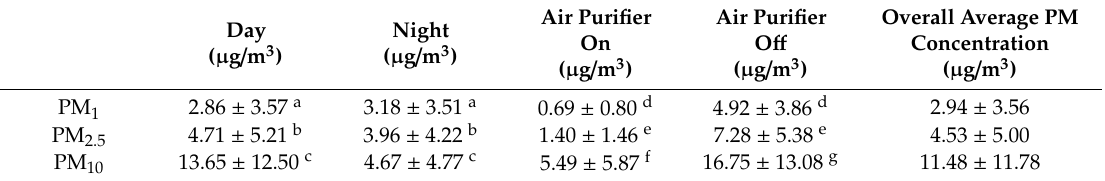
Table 2. Average PM concentrations recorded with the OPC-N3. The letters a–g show pairs for which statistical significance test was performed. The t -test showed that results were statistically significant at the 95% confidence